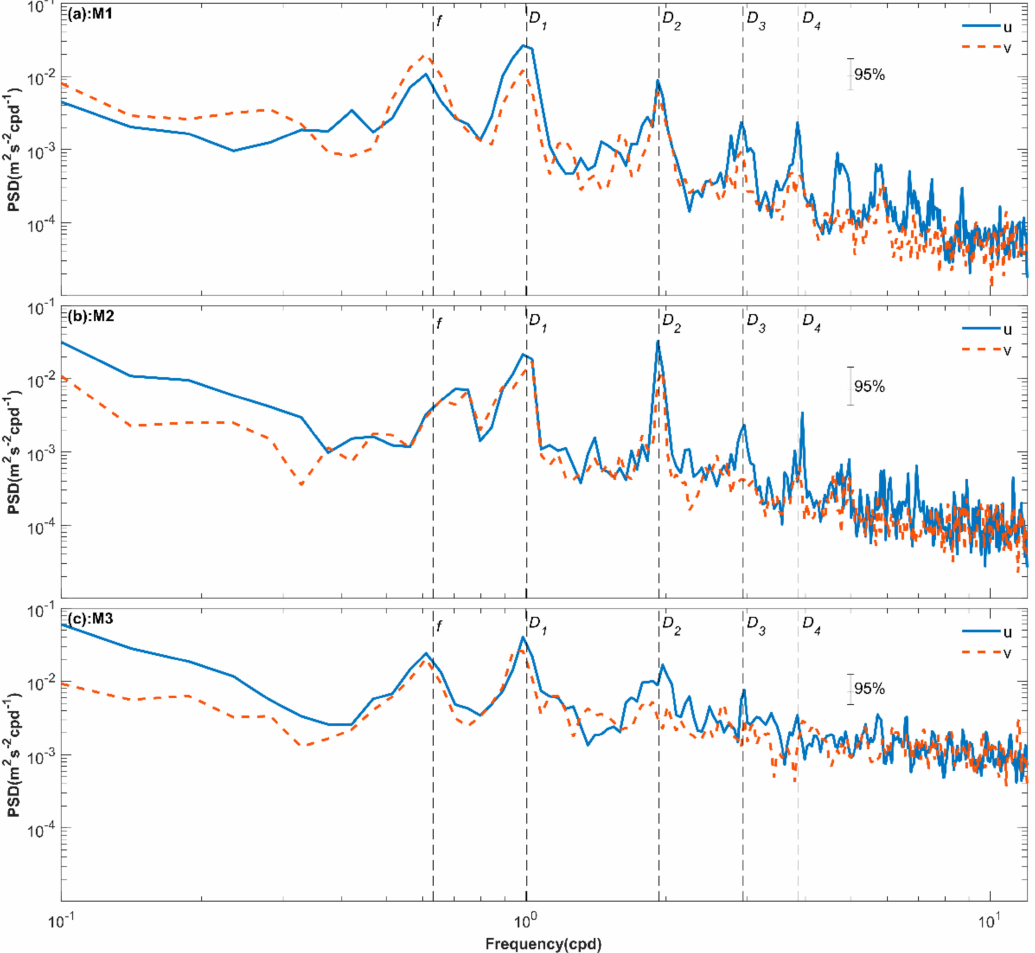
Figure 4. Depth-mean power spectra of zonal (red line) and meridional (blue line) horizontal currents with the barotropic tidal currents removed. The unit of the horizontal axis is cycles per day (cpd), and the vertical axis is the power spectral density (PSD) with units of m 2 s 2 cpd − 1 . The 95% confidence intervals are denoted by the vertical lines, and the near-inertial (f), diurnal (D 1 ), semidiurnal (D 2 ), one-third day (D 3 ) and one-fourth day (D 4 ) frequencies are shown by the dashed vertical